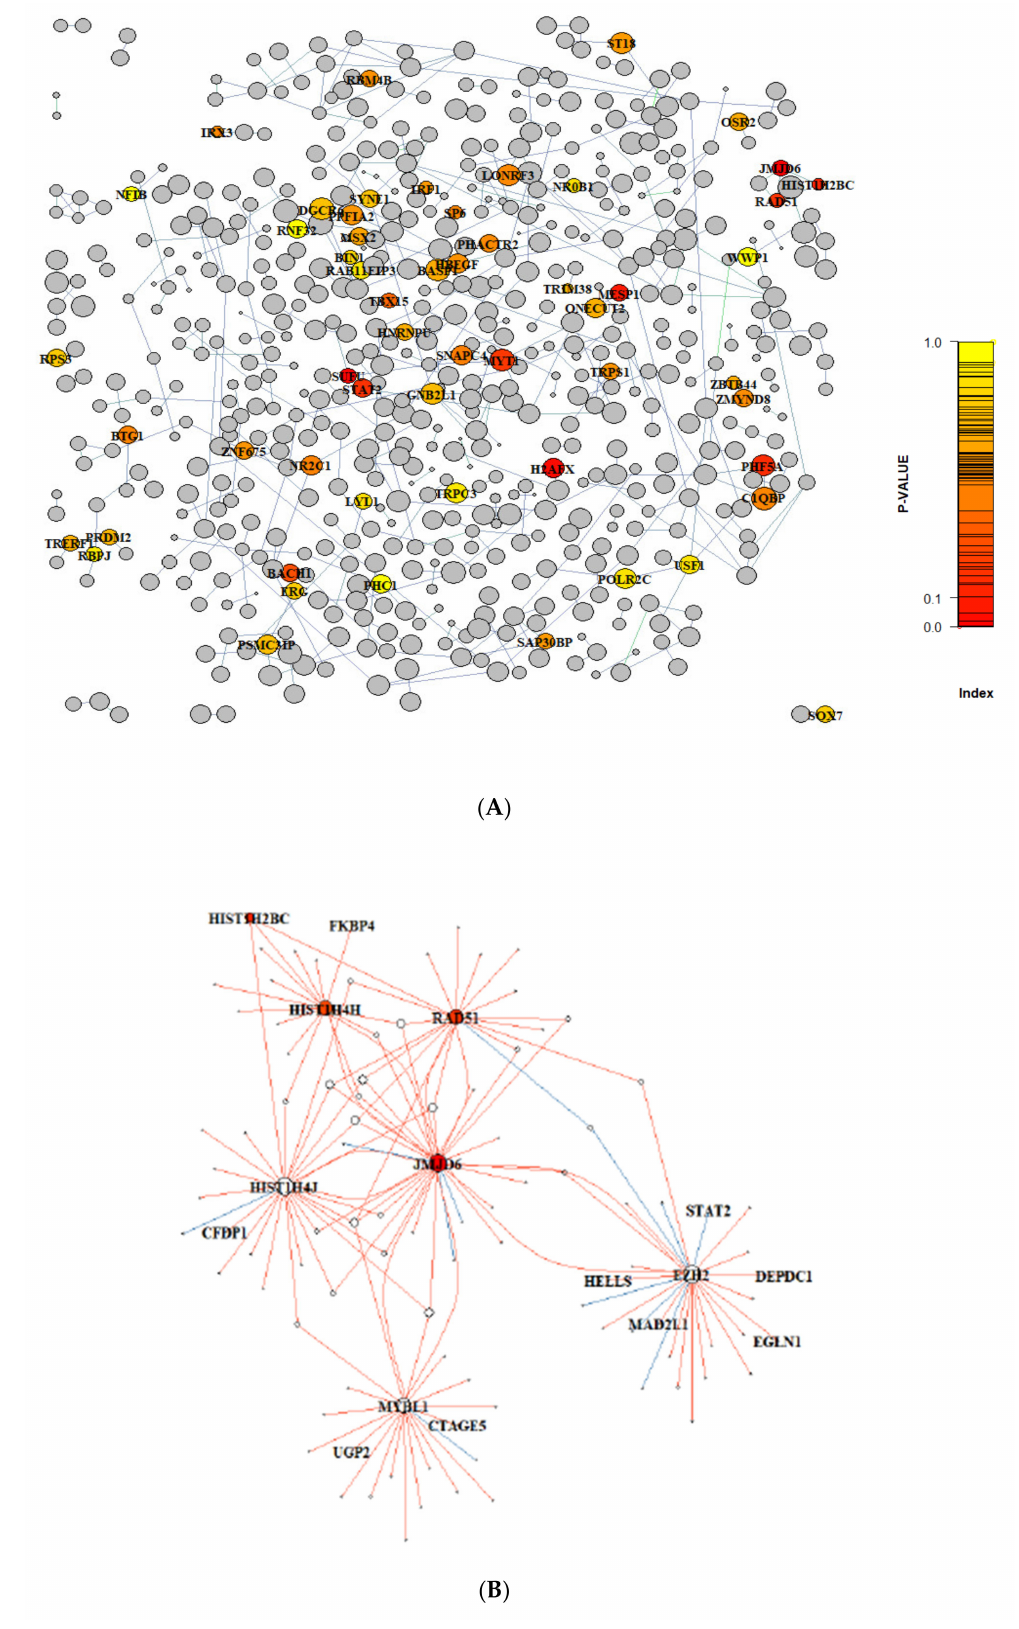
Figure 2. ( A ) Gene regulatory networks identified in preclinical human prostate cancer orthografts. The regulatory network of regulons (nodes of all colours) is presented with the edges linking pair of regulons sharing part of their targets. The commonality between pairs of regulons was calculated through the Jaccard index. Pairs with Jaccard Index ≥ 0.1 are